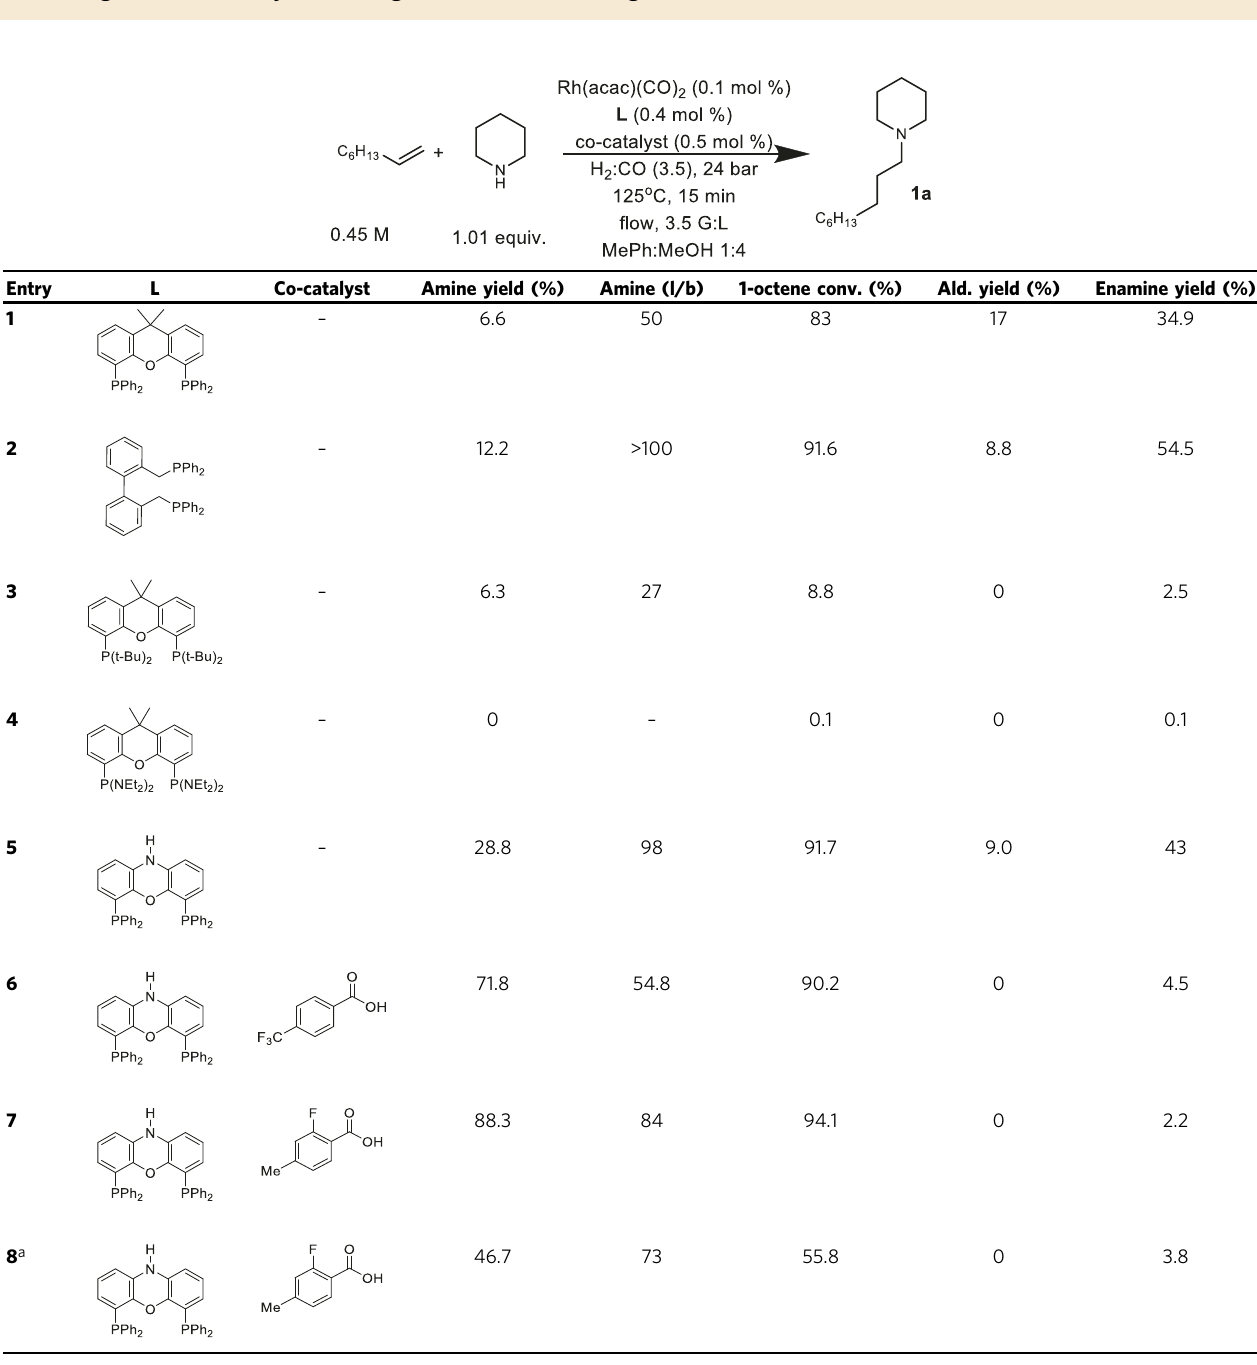
Table 1 Ligand and co-catalyst screening of HAM reaction in segmented fl